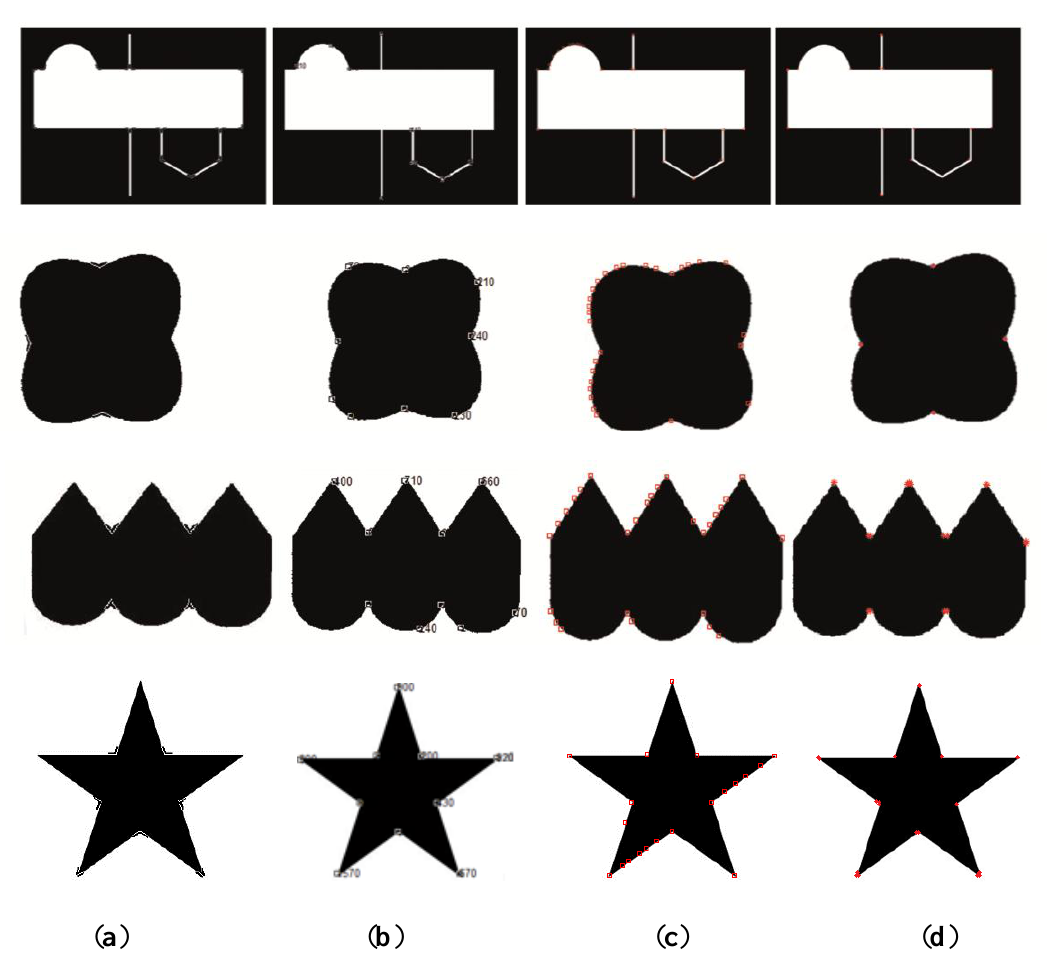
Figure 6. Results of the different corner detection techniques. ( a ) JUDOCA; ( b ) CPDA; ( c ) ANDD; ( d ) Proposed method.